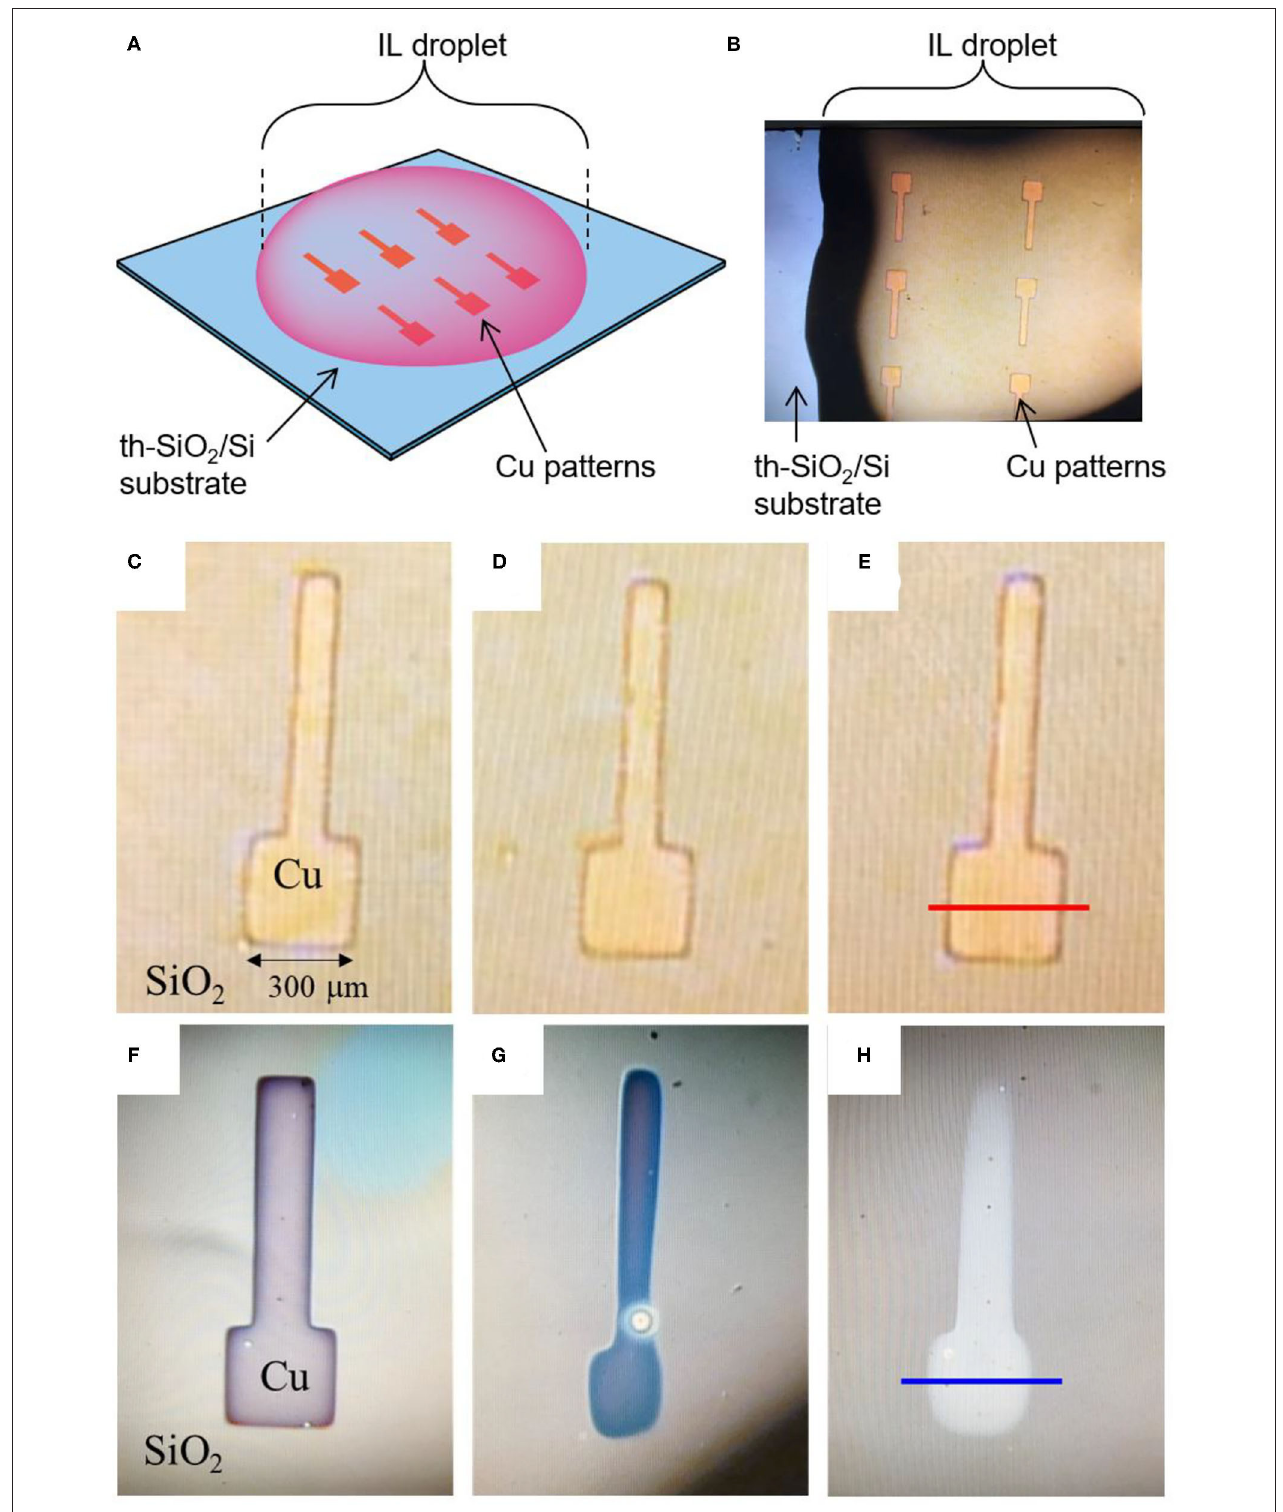
FIGURE 2 | (A) Schematic illustration and (B) photograph of Cu patterns immersed in the IL droplet. Magnified image of Cu thin film patterns (C,F) immediately after, (D,G) 15min after, (E,H) 60min after they were introduced into Cu(I)-IL and Cu(II)-IL, respectively. The thickness of Cu pattern is 50nm. When Cu pattern is in Cu(I)-IL, the appearance of Cu pattern exhibited almost no change with time. On the other hands, Cu pattern gradually disappeared in Cu(II)-IL. The red and blue horizontal lines in (E,H) correspond to the scan position for the surface profiles in Figures 3A,B .